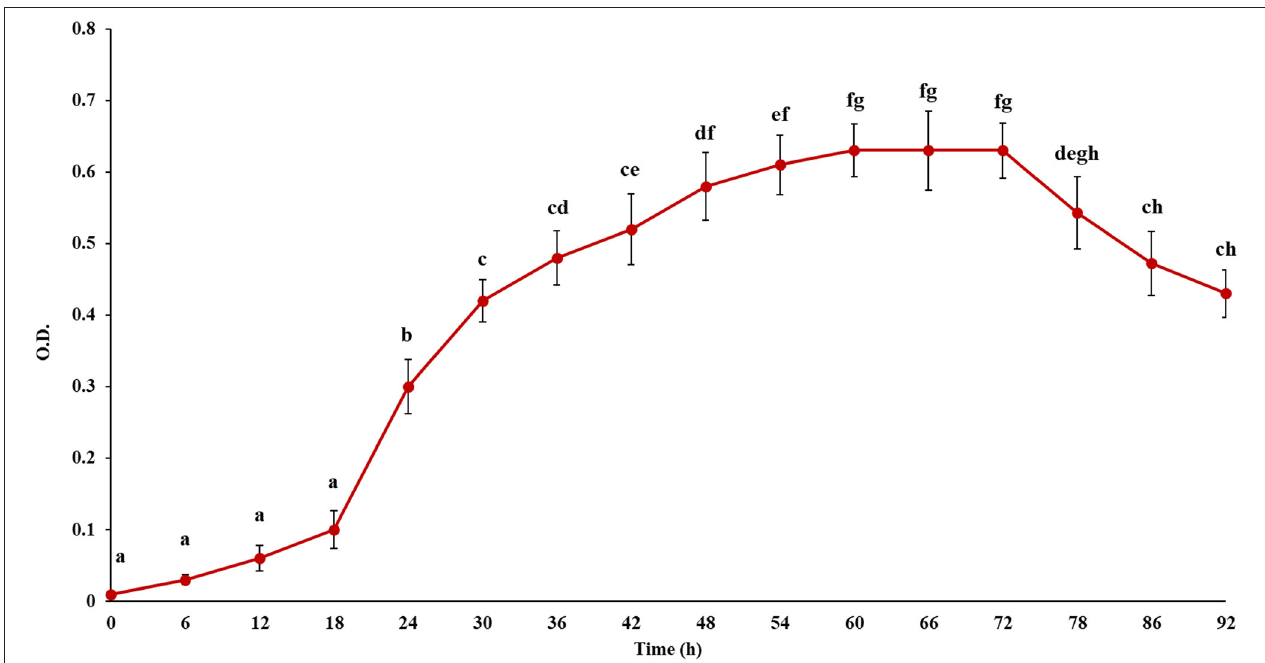
FIGURE 4 | Growth curve of the probiotic, Lactobacillus fermentum. Points sharing the same letter are not significantly different ( P < 0.05). Error bars represent standard deviation.